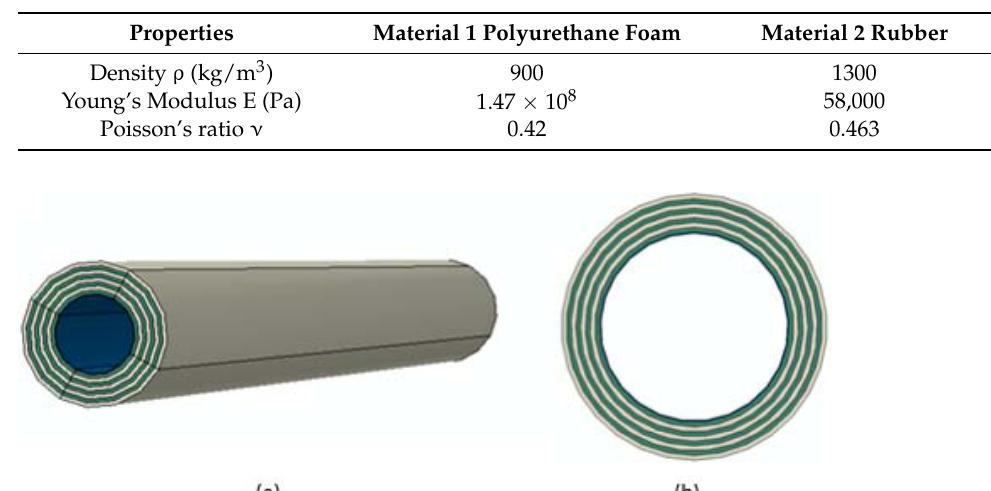
Table 1. Properties of the chosen materials for the meta-material layout.